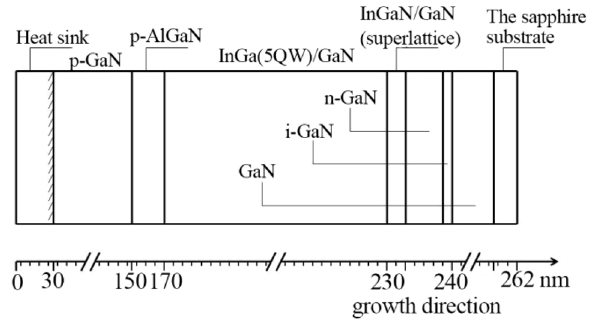
Fig. 1 InGaN/AlGaN/GaN/GaN semiconductor layer